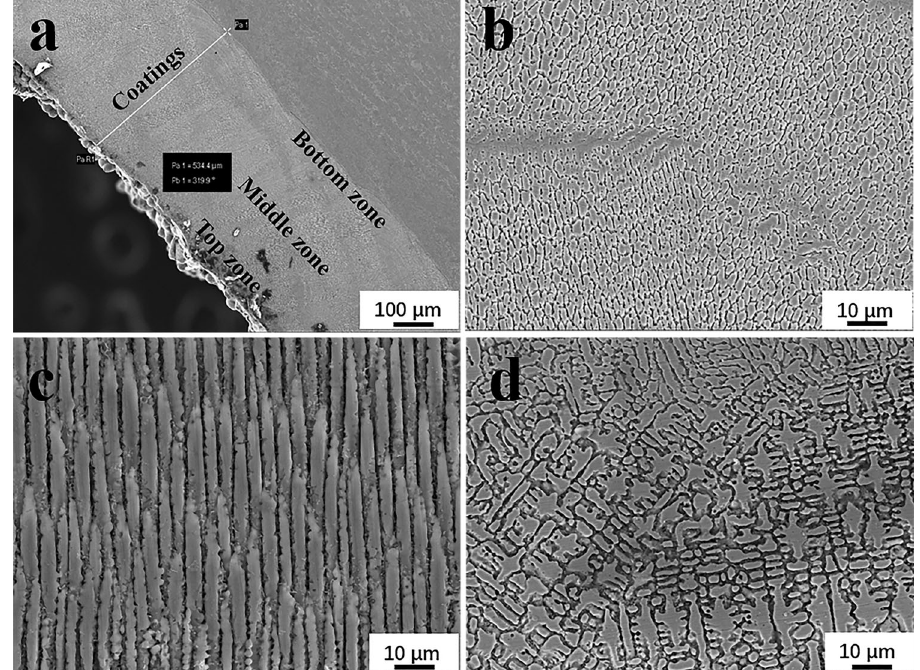
Fig. 2 FESEM images of Inconel 625 coatings on Q245R steel. a Cross-sectional; b bottom zone; c middle zone; d top